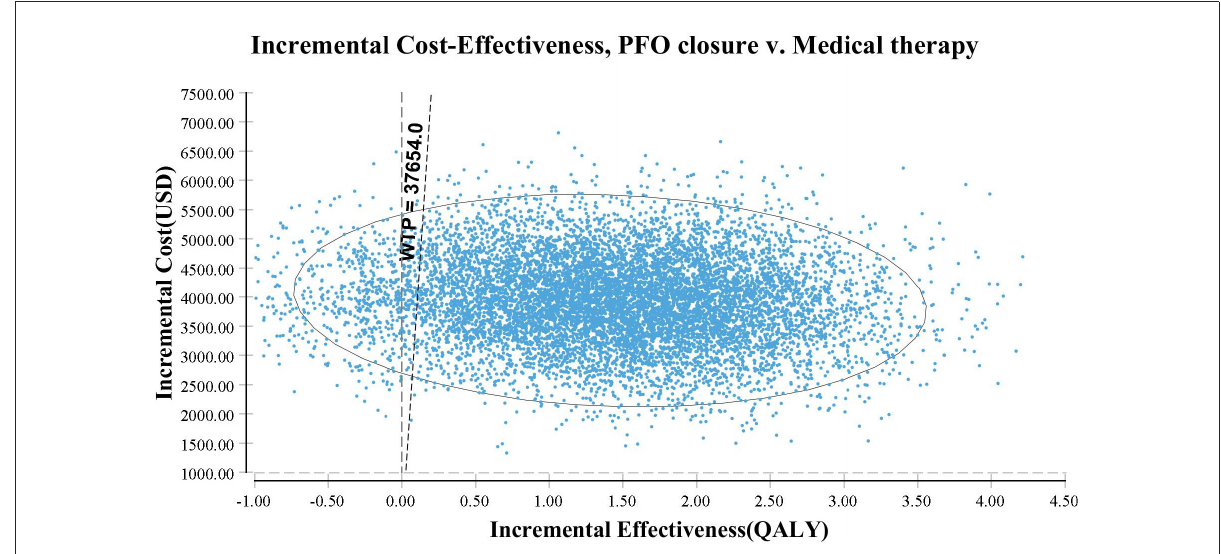
FIGURE4 A scatter plot based on probabilistic sensitivity analyses. The straight line represents the willingness-to-pay threshold of US